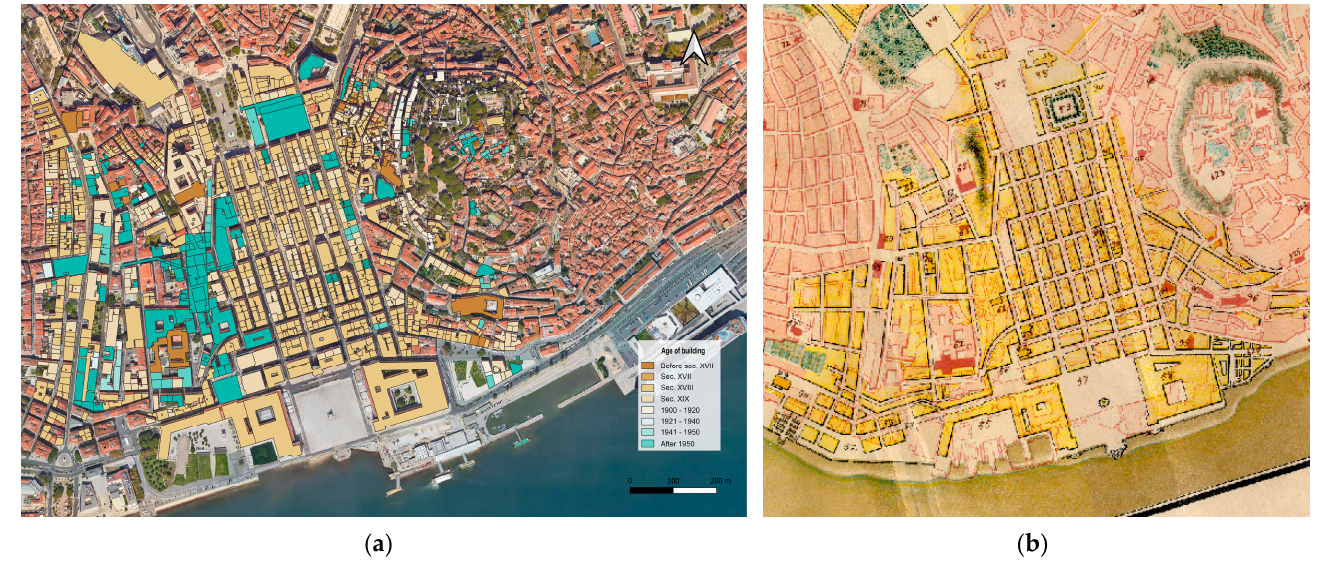
Figure 5. Current cartography of the Baixa of Lisbon with the dating of the individual buildings ( a ); historical cartography of the post-earthquake reconstruction of 1755 ( b ).